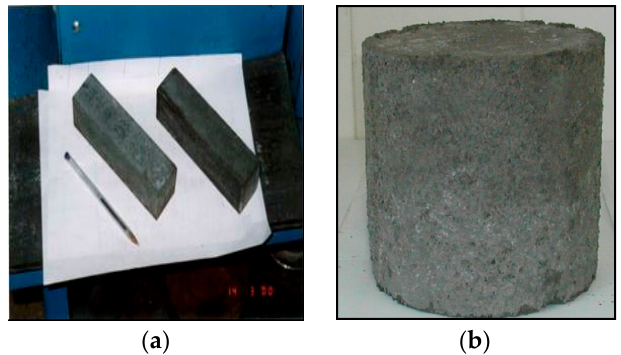
Figure 2. ( a ) Mortar prism (4 × 4 × 16 cm) ( b ) Compacted test tubes of bottom ash ( R = 7 cm, h = 15 cm).